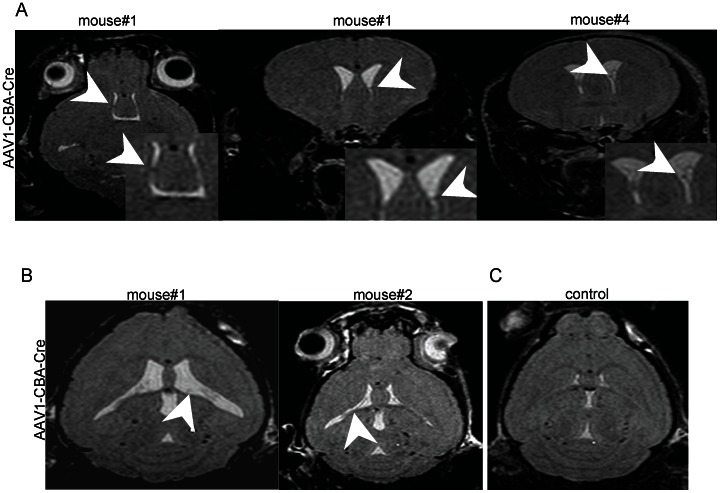
Representative MR images of AAV1-CBA-Cre and AAV1-CBA-GFP injected mouse brains.AAV1-CBA-Cre injected mouse brains (see Fig. 8 legend) showed abnormalities associated with the ventricular regions. (A) Multiple apparent subependymal nodules (arrowheads) were seen in the ventricles in the brains of two AAV1-CBA-Cre injected mice. First two images are from the same mouse. (B) Ventricles also appeared to have thickening of the ependymal lining (arrowheads; two left panels). (C) None of these abnormalities were observed in the control vector (AAV1-CBA-GFP)-injected brains.